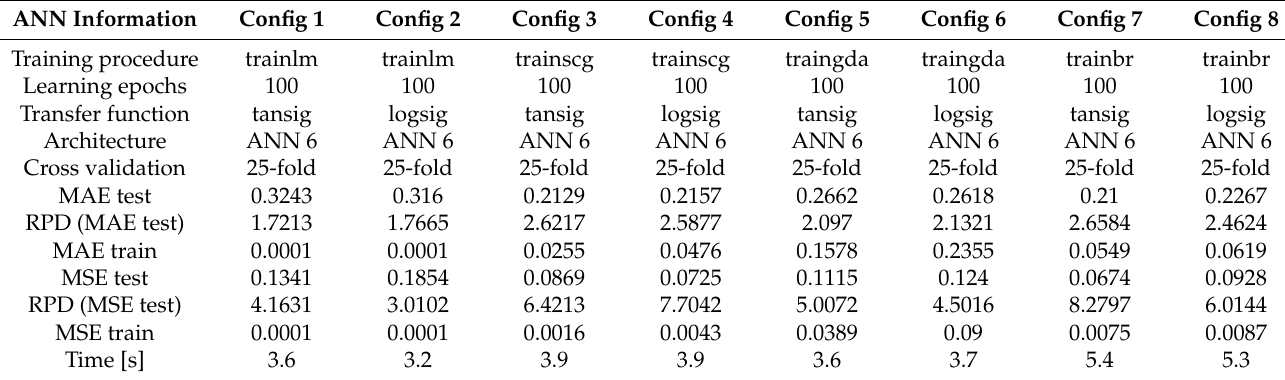
Table 9. Tested feedforward ANN